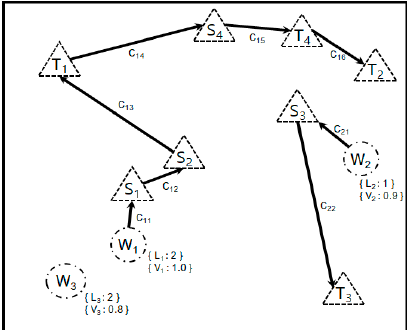
Figure 1. An example of the multi-agent ( 𝑀 = 3 ) and multi-job ( 𝑁 = 4 ) assignment problem.